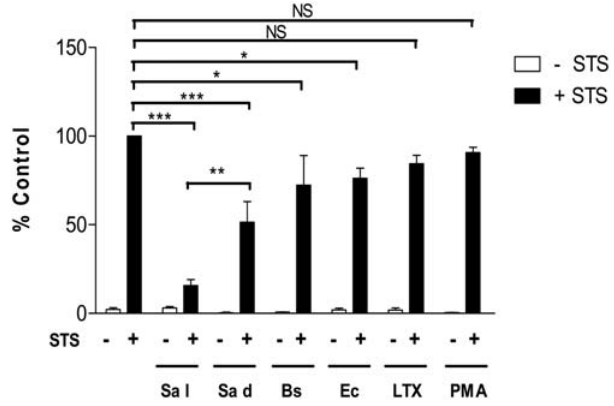
Figure 5. Inhibition of caspase-3 activation induced by STS in RAW 264.7 macrophages is dependent on S.aureus phagocy- tosis. The effect of live (Sa l) and heat-killed (Sa d) S. aureus , B. subtilis (Bs), E. coli (Ec) and latex beads (LTX) phagocytosis (MOI=1:5) on STS- induced caspase-3 activity in RAW 264.7. After phagocytosis cells were cultured for 24 h and treated with STS for 3 h. Caspase-3 activity was measured from cell lysates using DEVD-AFC as a substrate. STS-induced activity in control, resting cells was taken as 100%. Data are the mean 6 SD values from three independent experiments, each per- formed at least twice. *p , 0.05; ***, p , 0.001 significance as indicated in the figure.